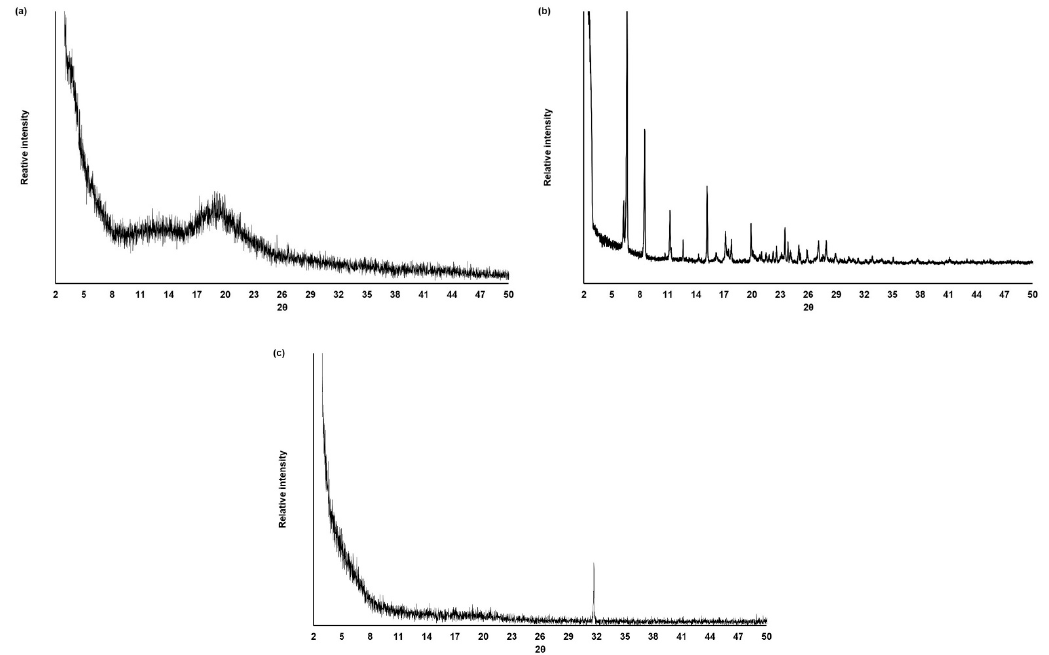
Figure 6. XRD diffractograms of the ( a ) cashew gum polysaccharide (CGP), ( b ) diclofenac sodium, and ( c ) CGP- PPG@diclofenac nanoparticles.